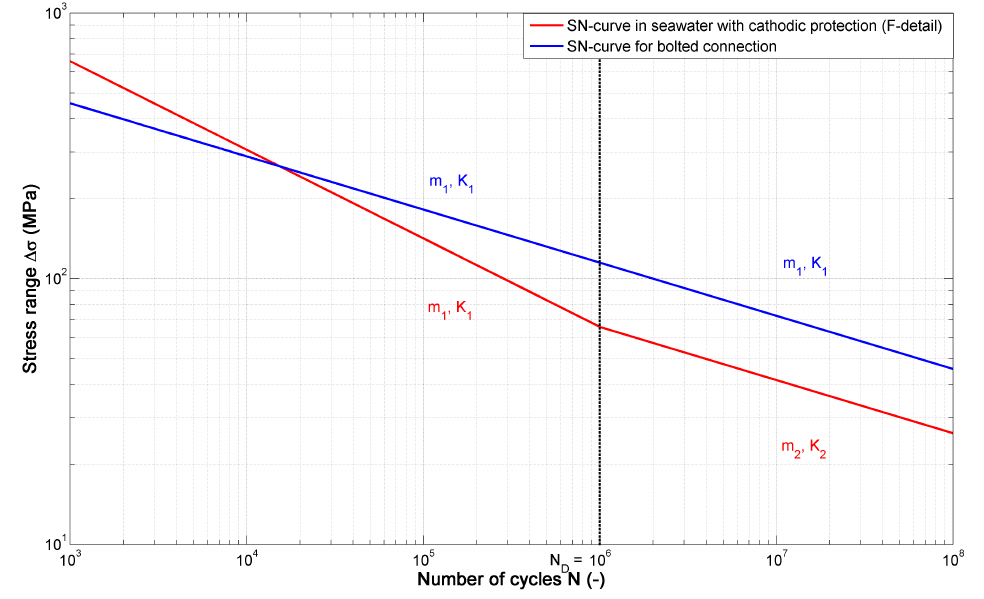
, m , K and K (see Equation (17)) are shown in Table 1 2 1 2